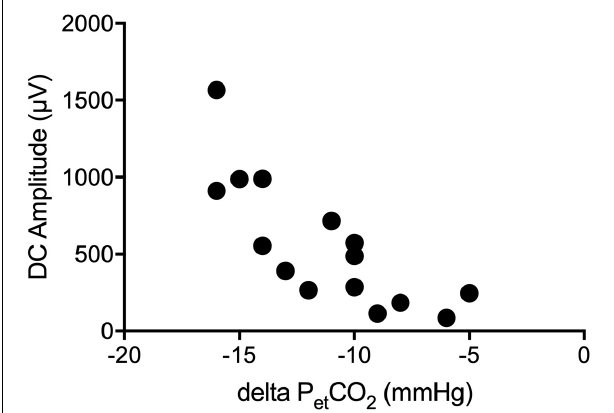
FIGURE 4 | Correlation of the DC-EEG and end-tidal CO 2 . The amplitude of the DC shift during hyperventilation (HV) increased the more the end-tidal CO 2 (p et CO 2 )